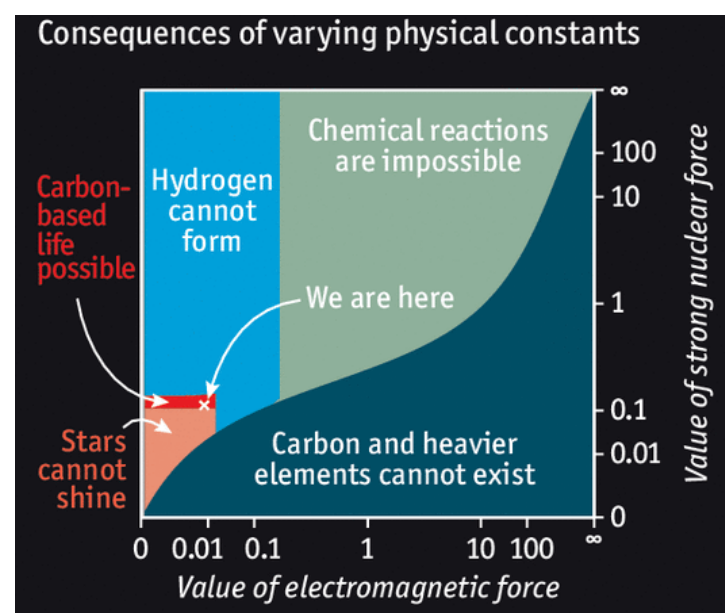
Figure 2. Fine-tuning of the parameters α and α s . Life-permitting parameter zone of these constants is marked in red